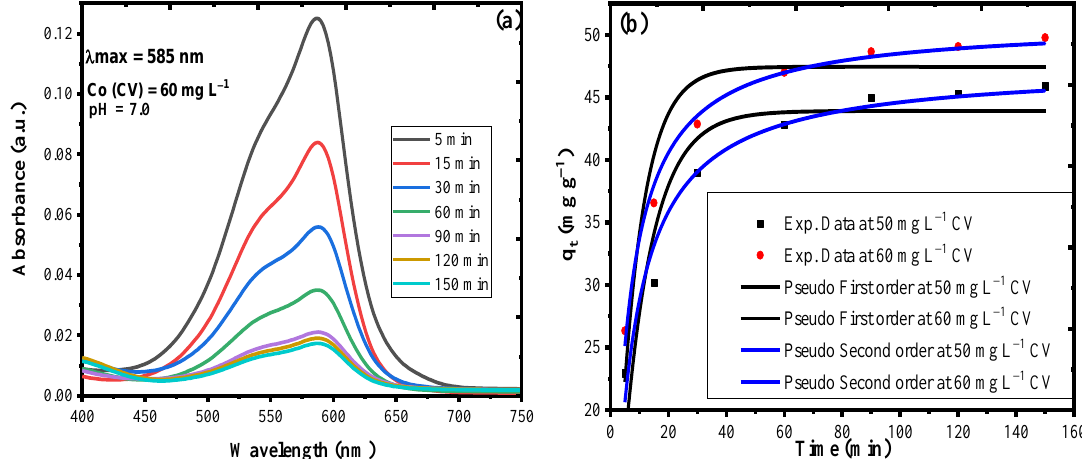
Figure 8. ( a ) Time-dependent UV–Vis spectra for CV adsorption. ( b ) Non-linear kinetic plot for pseudo first order (black line) and pseudo second order (blue line).